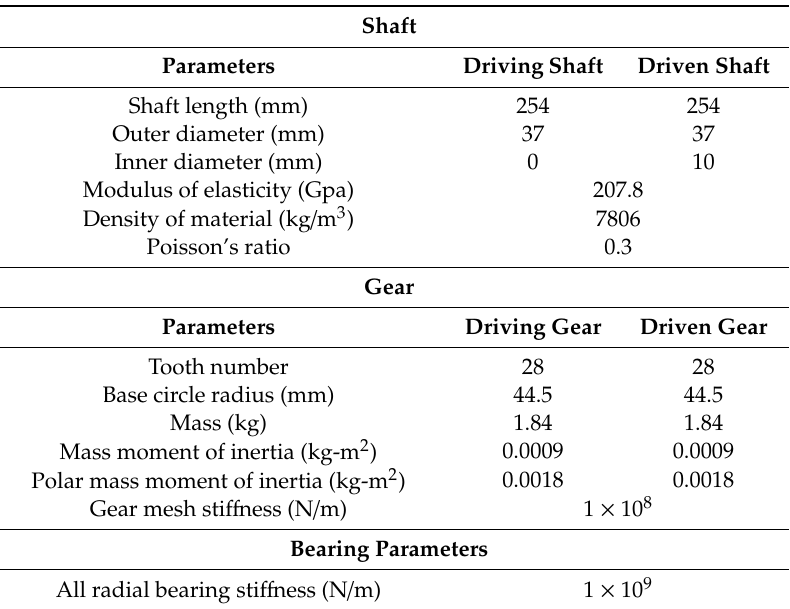
Figure 5. Dynamic model of the spur-geared rotor-bearing system. Table 2. Spur-geared rotor system parameters.